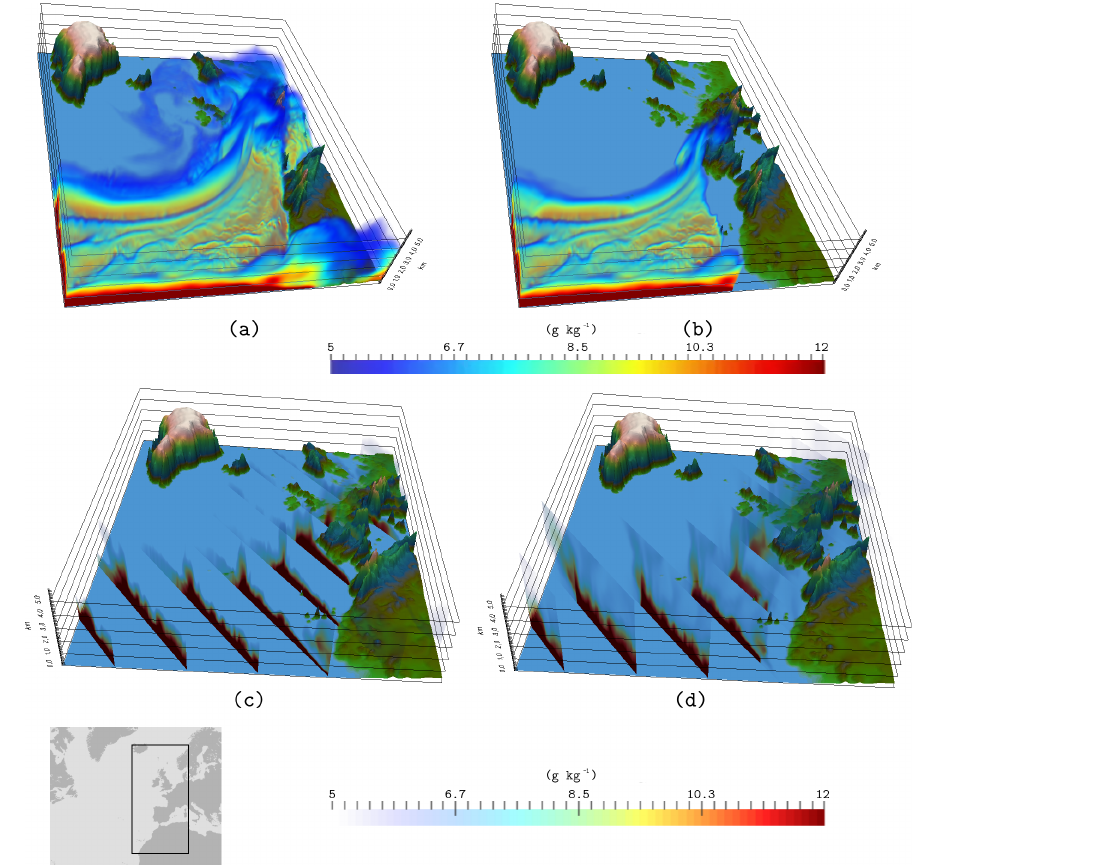
Figure 6. Same as Fig. 5 but for the European domain in the Great Storm of 1987 (15 October 1987 at 12:00UTC).